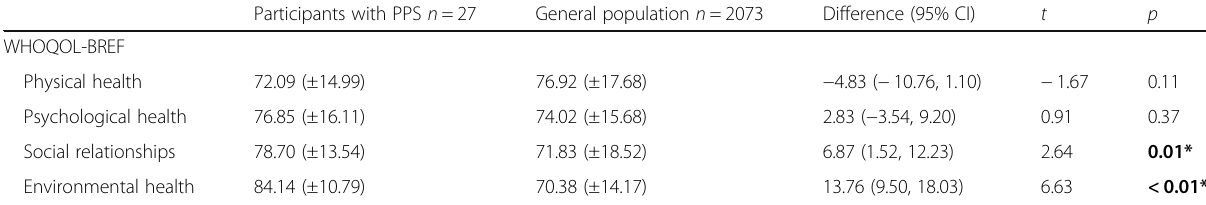
Table 2 Comparison of HRQOL scores among participants with PPS and healthy general population from normative data